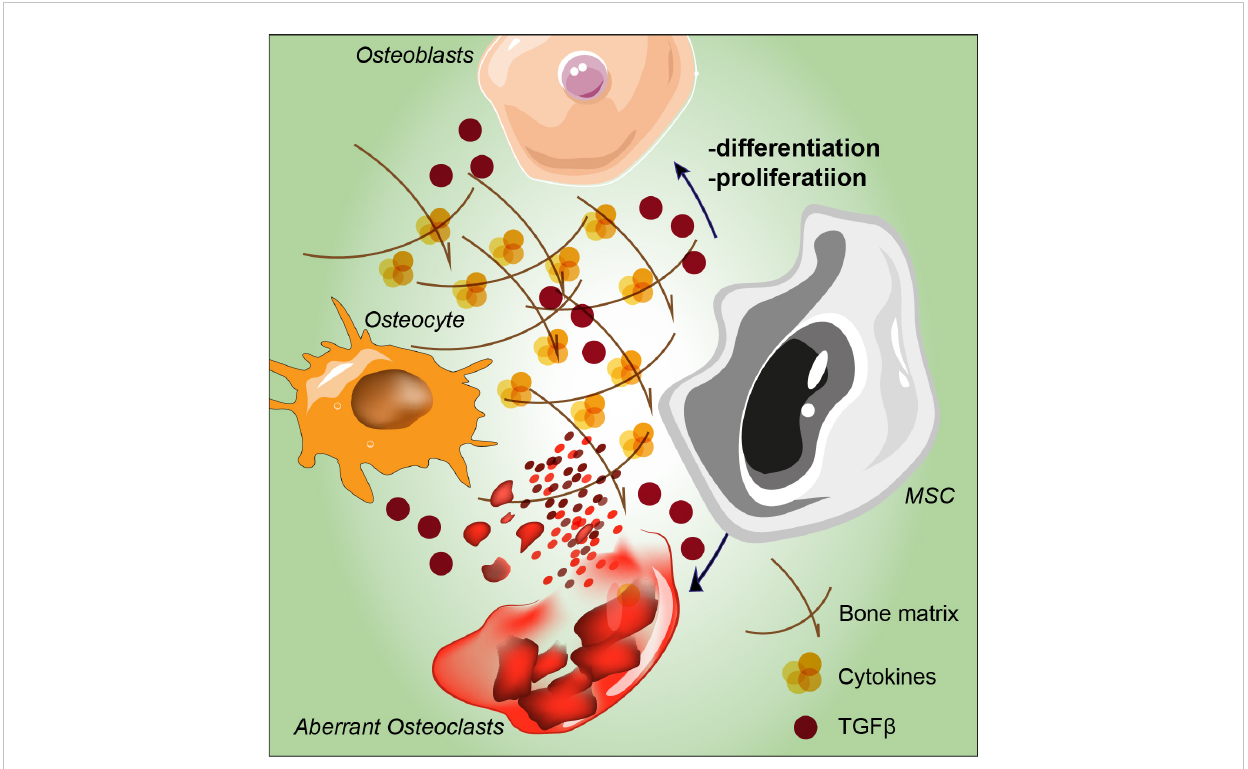
FIGURE 2 Schematic representation of MSC proliferation and differentiation abnormalities stimulated by tumoral hematopoietic cells. Aberrant osteolytic activity mediated by osteoclasts leads to bone remodeling and to altered osteocytes, overall contributing to the induction of osteosclerosis. MSC: mesenchymal stromal cell; TGF- b : transforming growth